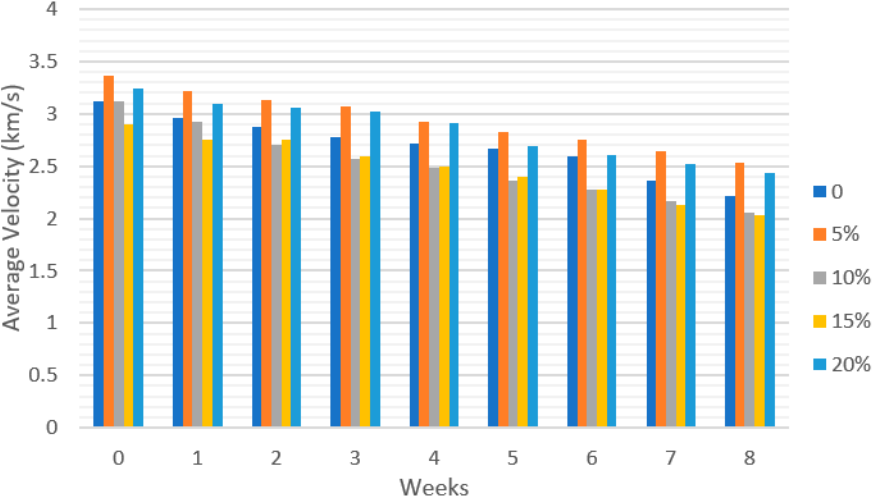
Figure 8. Average velocity versus FT cycles for AC with bentonite content variation (%).